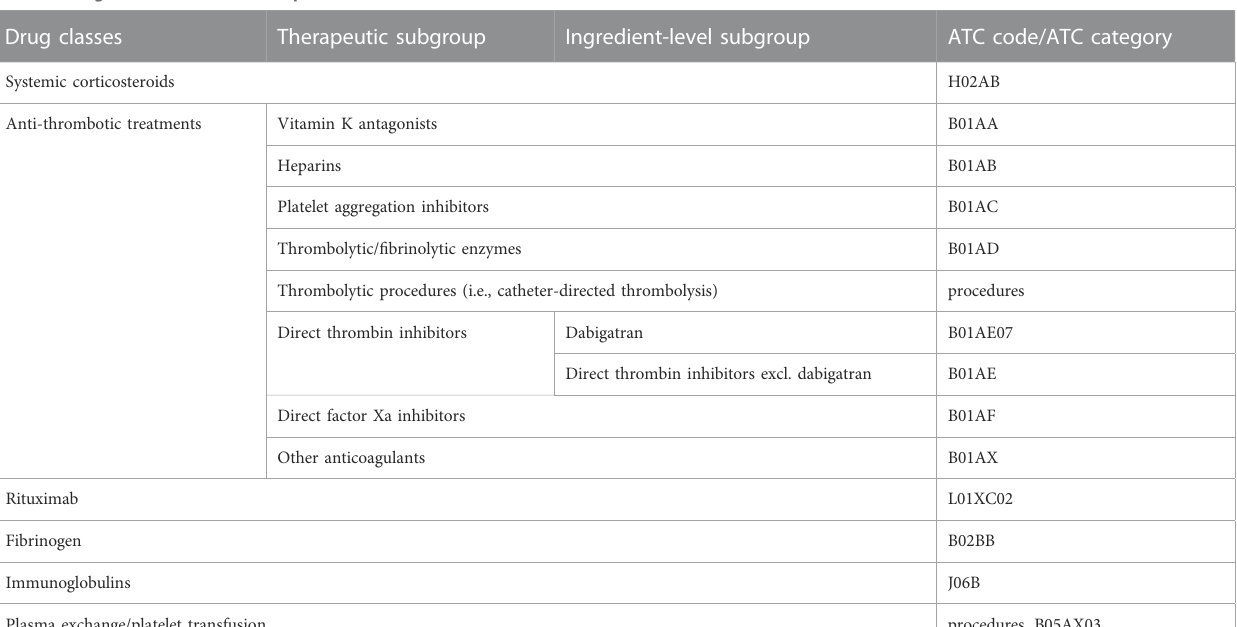
TABLE 2 Drug classes, medicines and